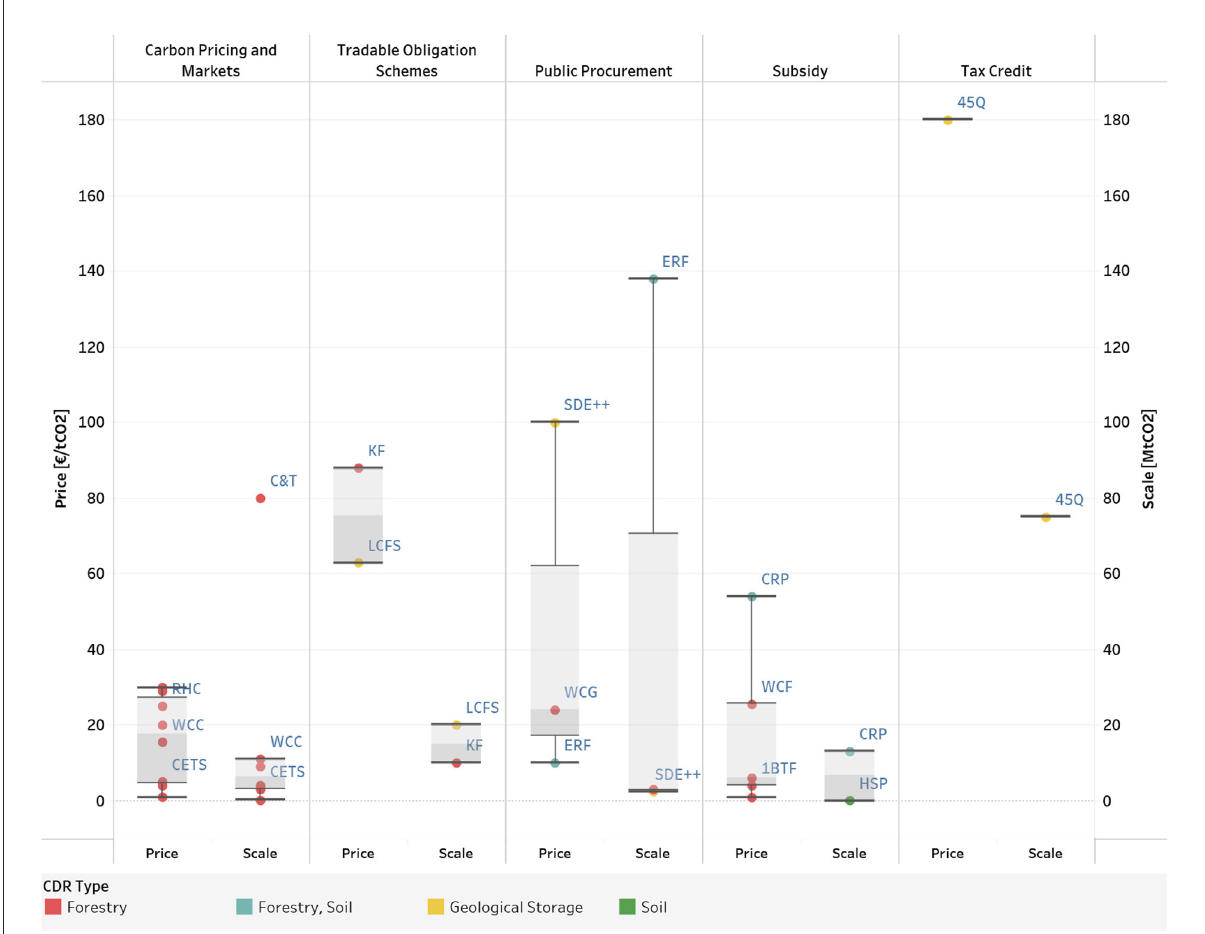
FIGURE3 Current potential scale and price by mechanism type (converted from base currency to e in September 2022).